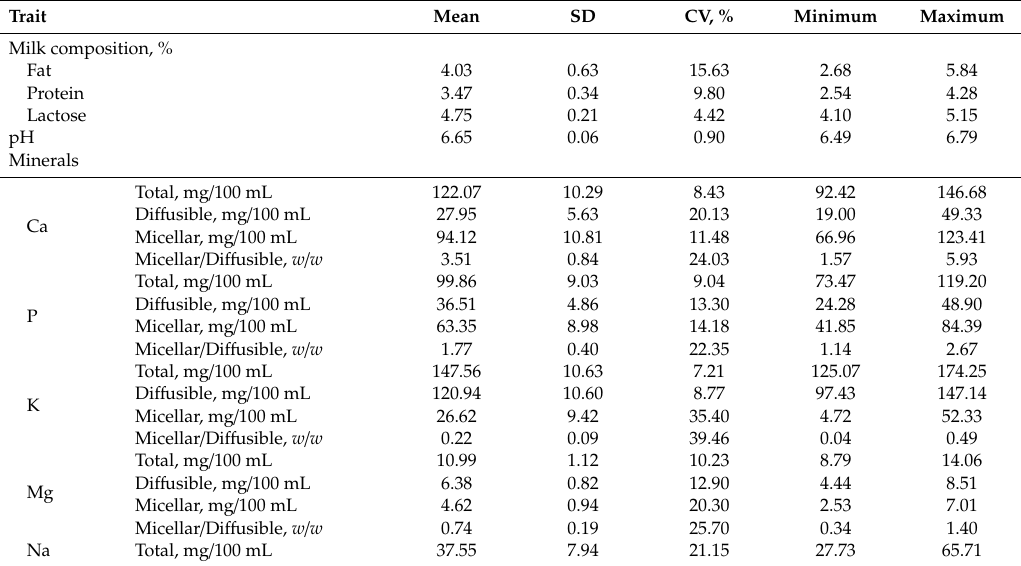
Table 1. Descriptive statistics of milk composition, milk minerals (mg / L) and ratio between micellar and di ff usible fractions ( w / w